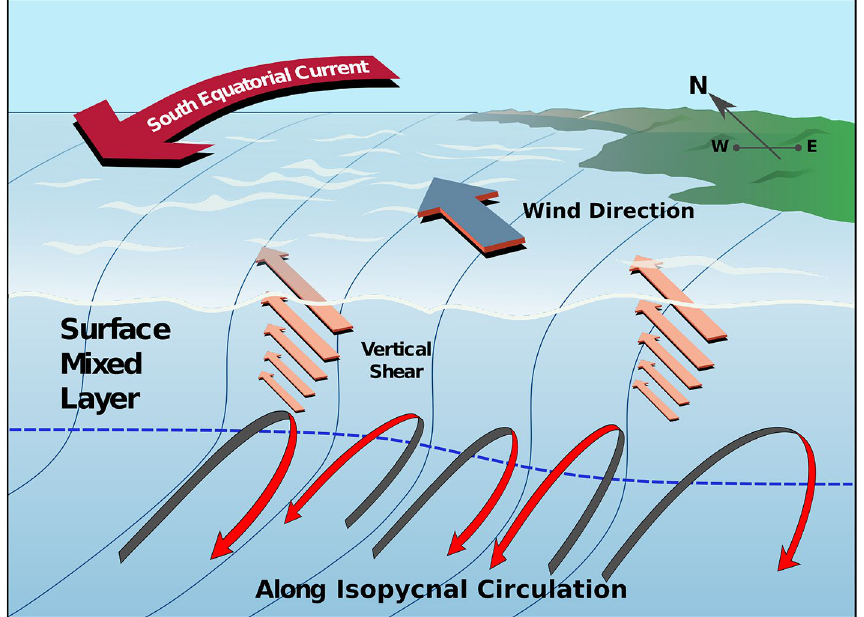
Figure 6. Schematic of the mechanism of wind forcing of Galápagos upwelling. Meridional wind-driven shear in the upper ocean is directed along density fronts near the islands’ western margin, set up by the archipelago’s blocking of the westward-flowing South Equatorial Current. The interaction of the winds with the fronts results in a deepening of the surface mixed layer and the development of (submesoscale) symmetric instability, which induces re-stratifying overturning flows along the sloped isopycnals. The localised mixed layer deepening and along-isopycnal flows promote upwelling of deep waters toward the